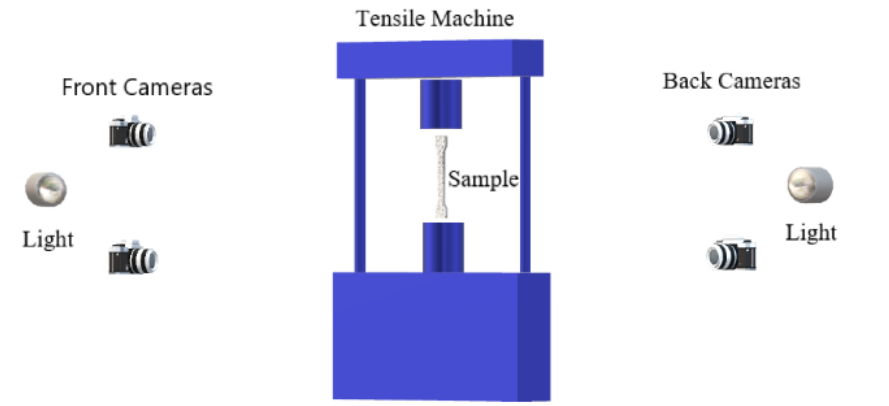
Figure 8. Schematic diagram of the experimental system.